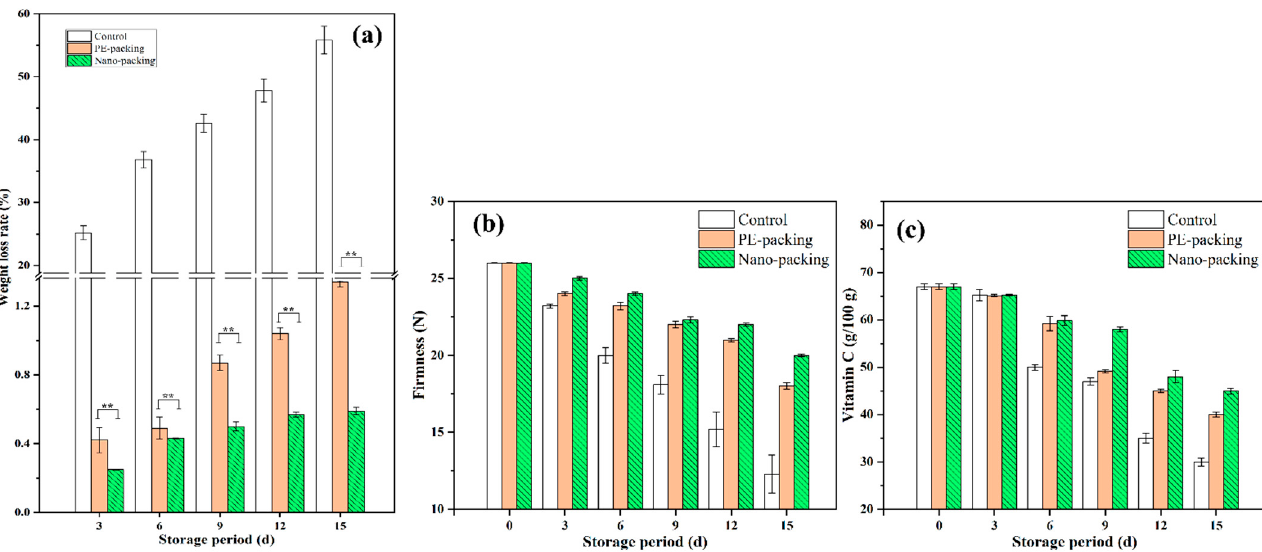
Figure 2. Bar charts of weight loss rate ( a ), firmness ( b ) and Vc ( c ) of mini-Chinese cabbage during storage from 0 to 15 d. * and ** indicate significant difference at p < 0.05 and p < 0.01, respectively. Data are expressed as mean ± standard error.